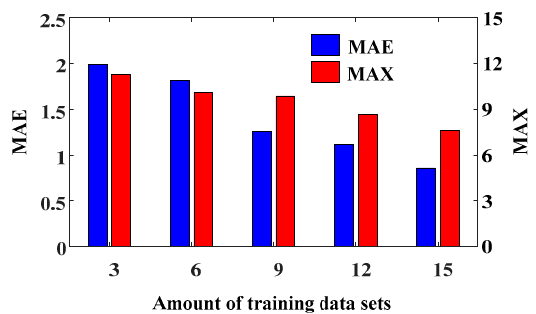
Figure 13. Performances at different sizes of training data.